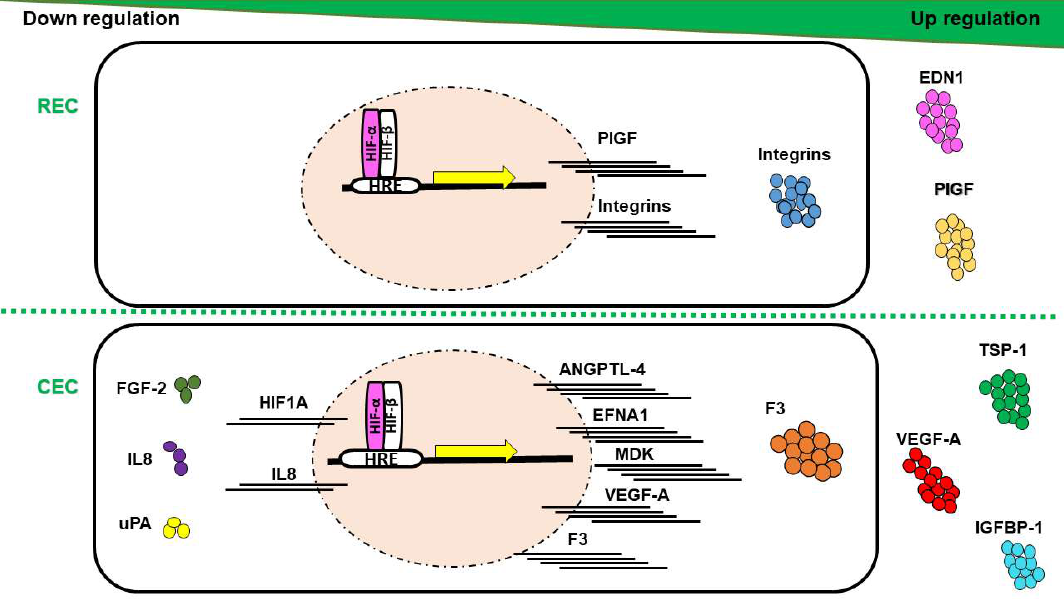
Figure 3. Schematic depiction of angiogenesis-related mRNA, and intracellular and soluble protein expression profile in response to hypoxia (yellow arrow) compared between retinal endothelial cell (REC) and choroidal endothelial cell (CEC). Lines: mRNAs; circles: proteins.